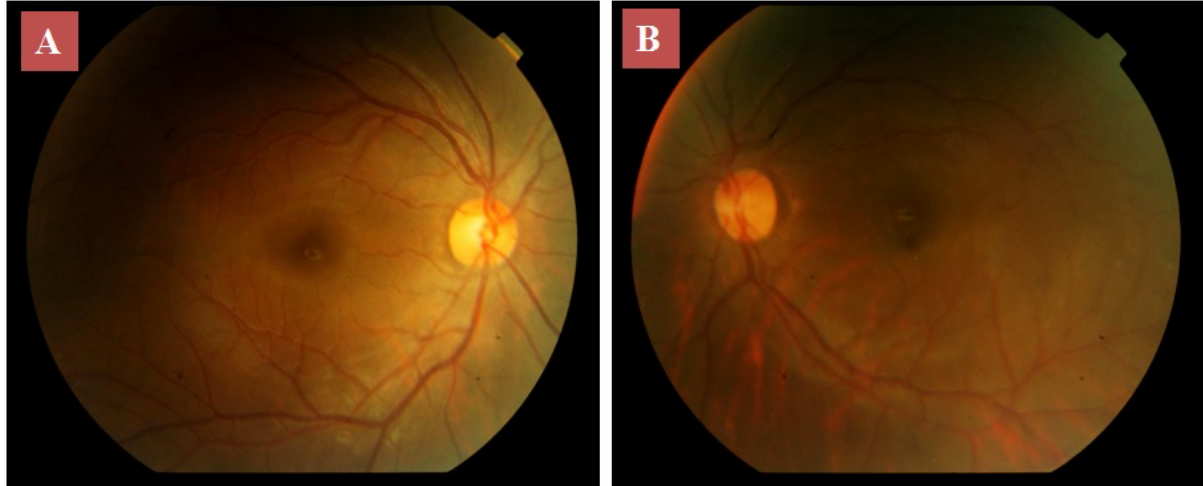
Figure 2: Posterior segment photograph of the right (A) and left (B) eye showing pigmentary changes at the